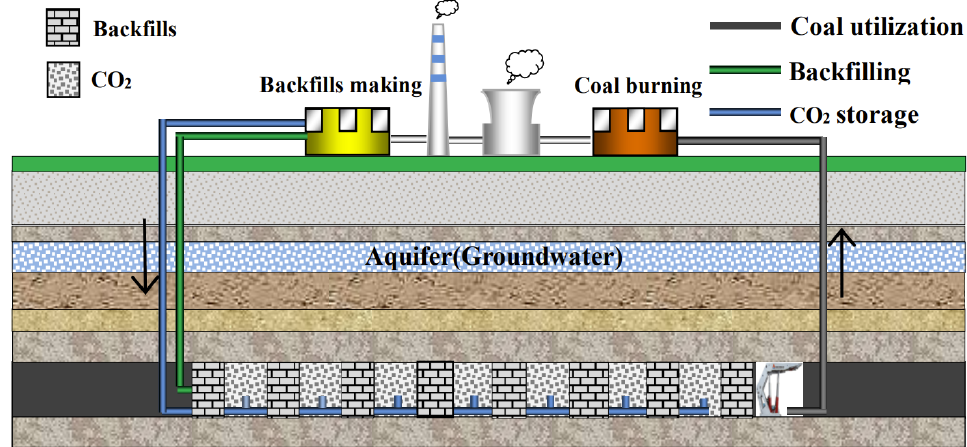
Figure 2. Innovative mode of green mining and low-carbon utilization for coal resources in large coal power bases.